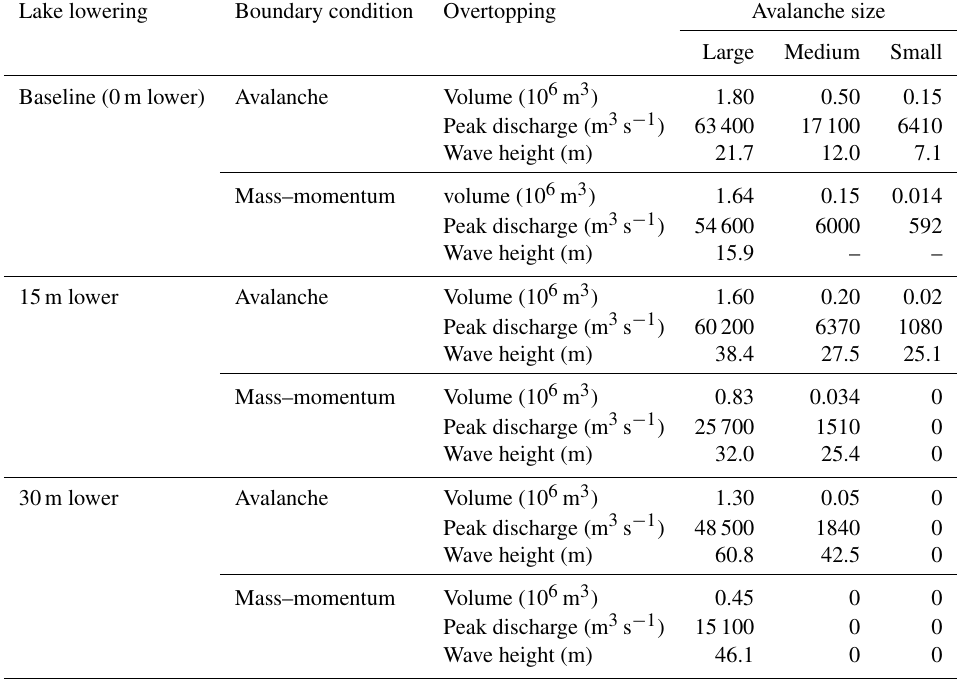
Table 2. Overtopping characteristics of three simulated avalanche events of different size for the current lake level and lake-lowering scenarios (after Somos-Valenzuela et al.,